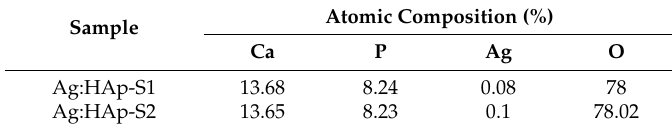
Table 2. The elemental composition estimated from X-ray Energy Dispersive Spectroscopy (EDX) analysis. Atomic Composition (%) Sample Ca P